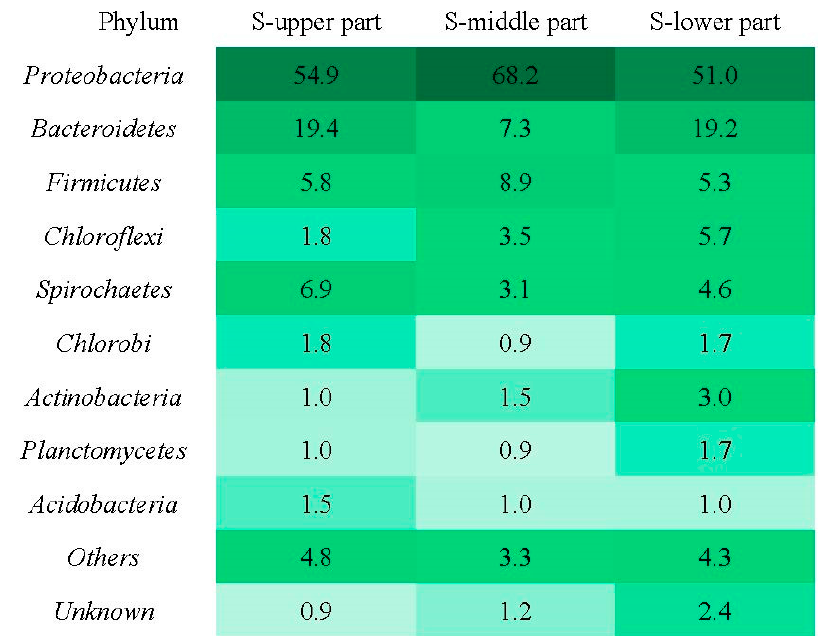
Figure 16. Microbial community structure at the phylum level at different heights in the pilot-scale bioreactor.